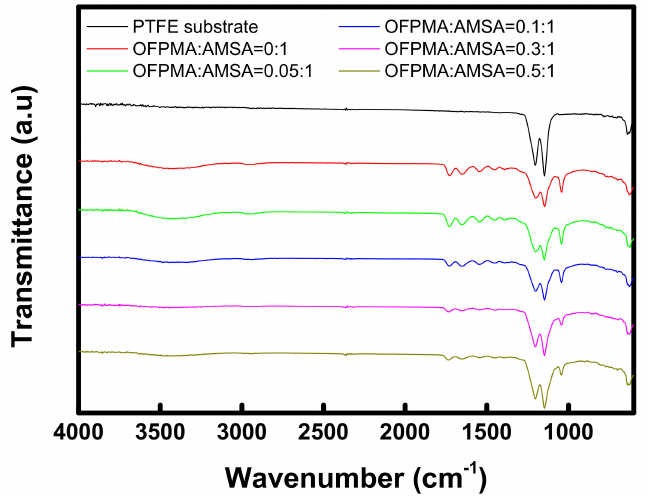
Figure 3. FT-IR spectra of the porous substrate and prepared